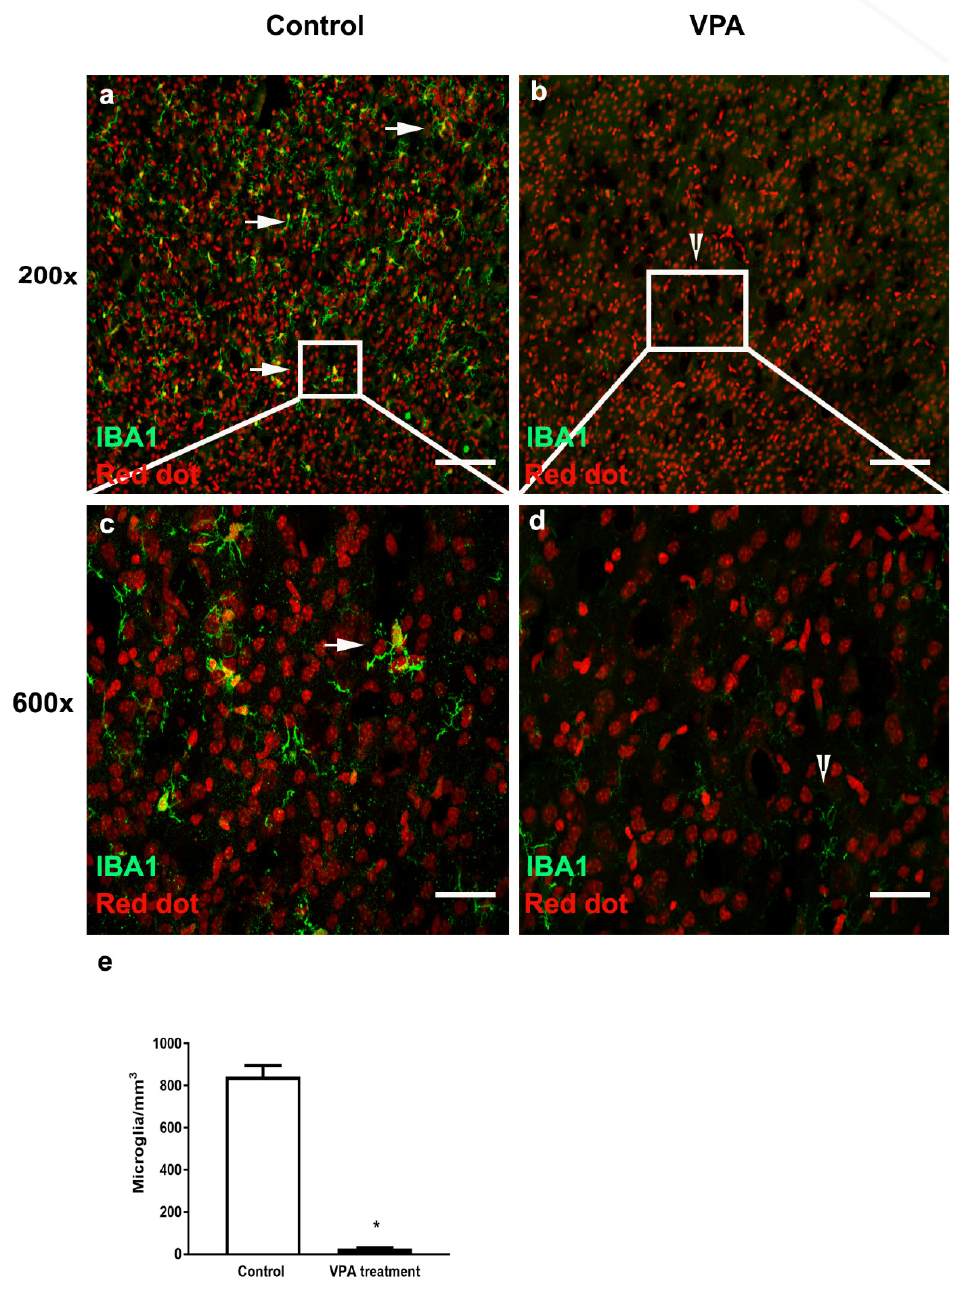
Figure 2. VPA-treated male mice show significant decrease in microglial number and fragmented morphology in primary motor cortex at P10. Confocal images showing labeled microglia in cortex of saline control and age matched brains in VPA mouse model of autism. ( a , b ) Microglia labeled with Iba1 (green) in control mice and VPA-treated mice at low magnification (200 × ). ( c , d ) Microglia labeled with Iba1 (green) at high magnification (600 × ). White square region (insert) in a and b is magnified in c and d. White arrows and arrowheads indicate differences in morphology of microglia in control and VPA model. Scale bar ( a , b ) 200 µ m and in ( c , d ) 50 µ m. ( e ) Analysis of number of microglia as summarized within the bar graphs (Mean ± SEM) reveals a statistically significant decrease in microglial number in VPA-treated mice (* p = 2.3 × 10 − 9